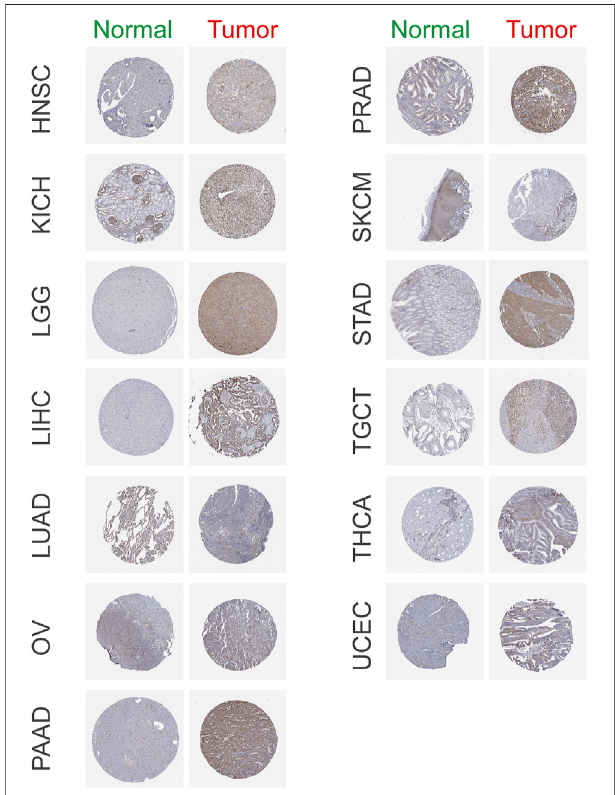
FIGURE 4 | Representative immunohistochemistry images of STC2 in HNSC, KICH, LGG, LICH, LUAD, OV, PAAD, PRAD, SKCM, STAD, TGCT, THCA, and UCEC based on The Human Protein